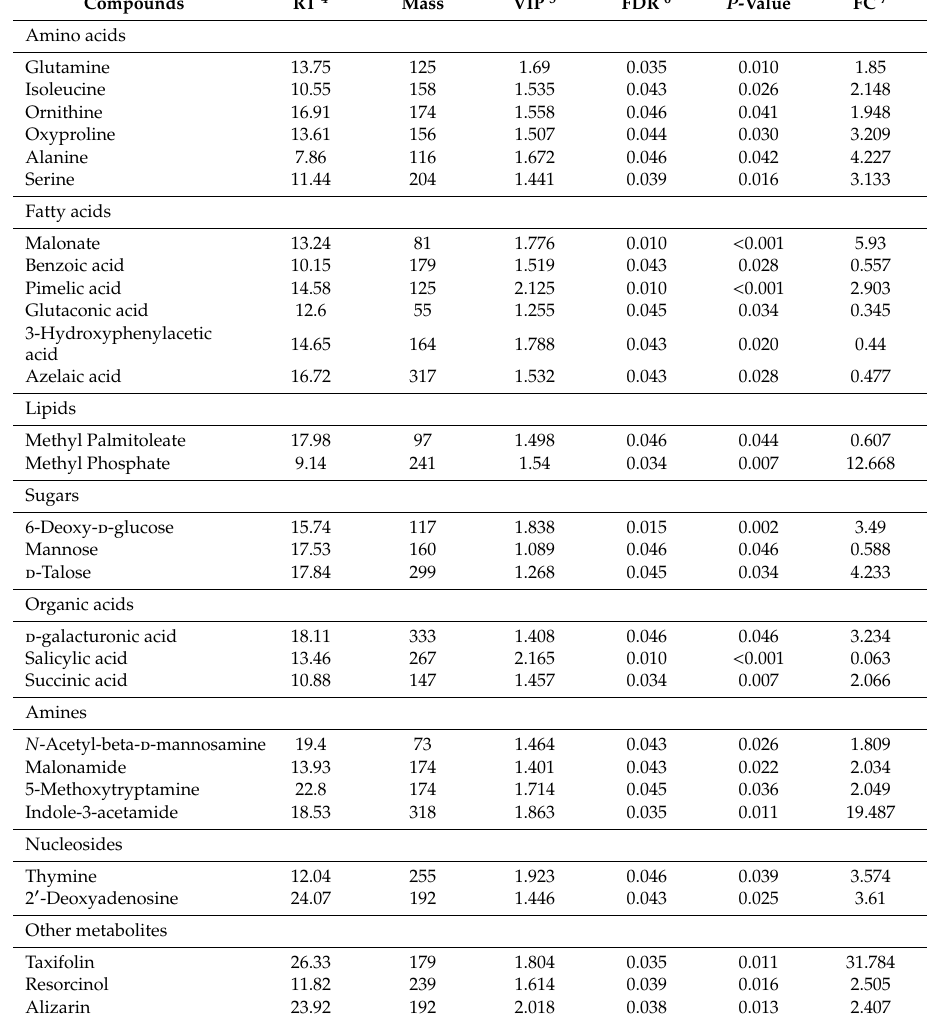
Table 7. List of ruminal fluid metabolites that showed significant di ff erence between CON 1 and TR 2 groups 3